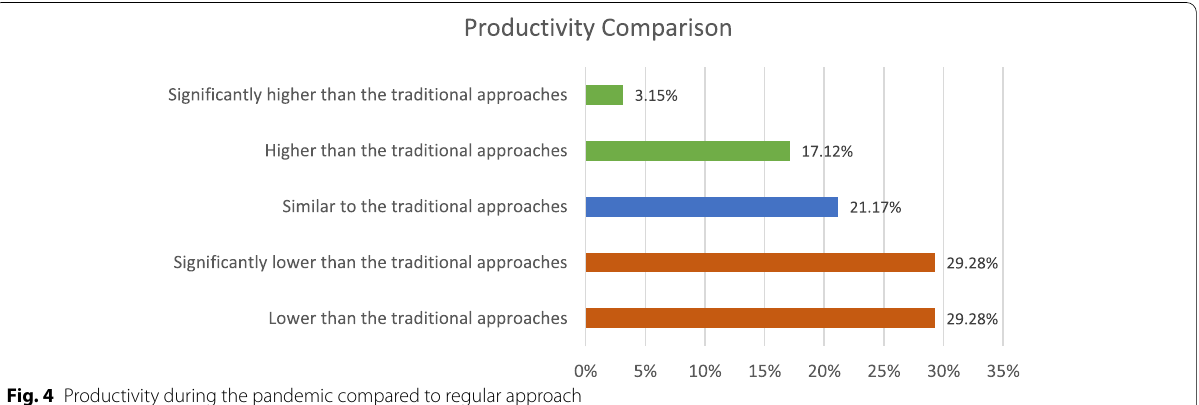
Fig. 4 Productivity during the pandemic compared to regular